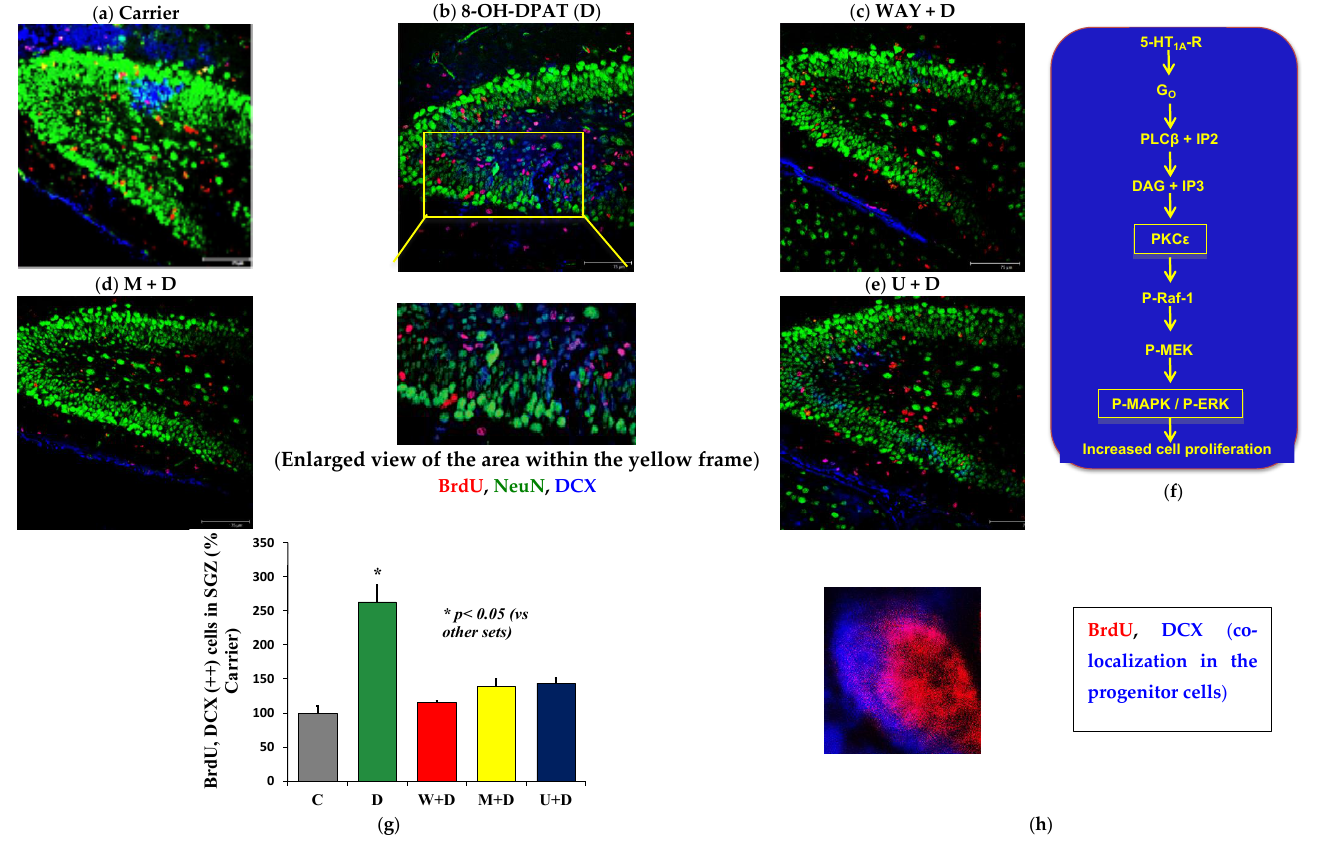
Figure 4. Stimulated 5-HT 1A -R elicits PKC ε and ERK1/2-mediated neuroproliferation in P6 DG. C57BL/6 P6 pups were injected (i.p.) with BrdU 2 h before intra-hippocampal infusion of D (100 nM) in the absence or presence of the inhibitors. ( a – e ) Number of neuroblasts proliferating in P6 DG 24 h after intra-hippocampal infusion of carrier (vehicle) or D in the absence ( b ) and presence of W ( c ), M ( d ) and U ( e ). ( b ) (enlarged) Neuroproliferation was shown by the co-localization of BrdU (red) and DCX (blue) yielding a pink–purple color. ( f ) A diagrammatic representation of the 5-HT 1A receptor-signaling cascade highlighting the hierarchy of the key players PKC ε and MAPK/ERK. ( g ) Mean BrdU, DCX (++) cell number in the hippocampal DG per section from nine sections per mouse pup was used for statistical analysis. We used three mice per treatment ( n = 3) (see results for details); (One-way ANOVA: F(4,10) = 67.17, p < 0.0001). Post-hoc analysis showed p < 0.05 for D compared to the other groups (inset). Scale bar: 75 µ m. ( h ) Enlarged image of a BrdU, DCX (++) cell showing BrdU localization in the nucleus and DCX staining in the